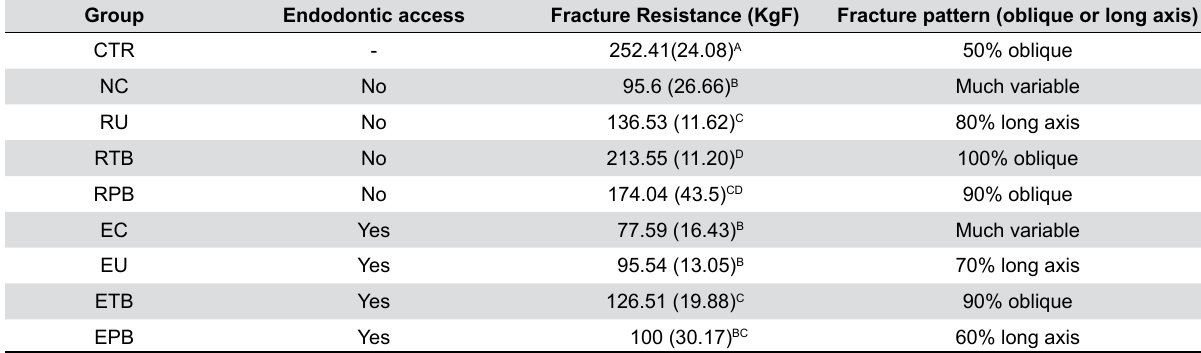
Table 1- Mean values (standard deviation) of fracture resistance and fracture pattern of teeth without and with endodontic